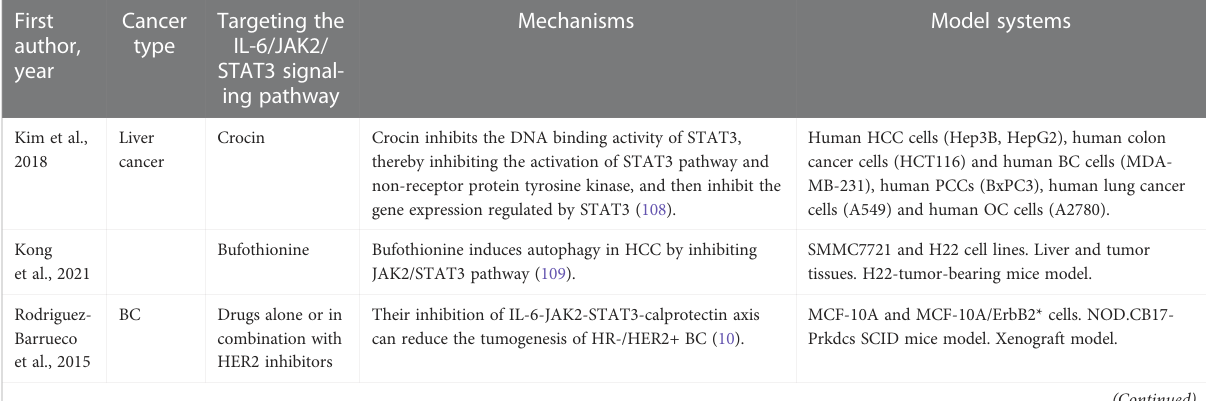
TABLE 2 Targeting the IL-6/JAK2/STAT3 signaling pathway in